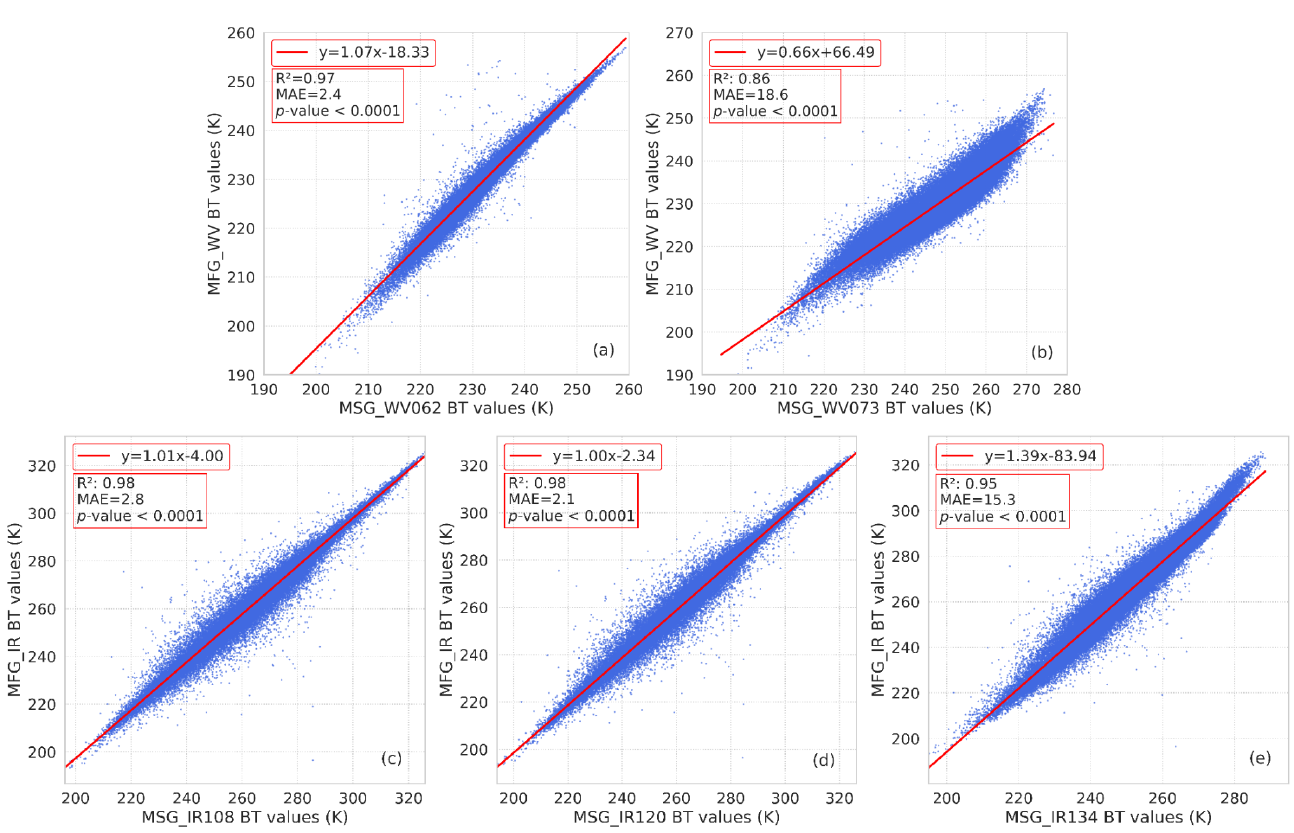
Figure 7. Scatter plots of MFG-MSG channels BT values (K). ( a ) MSG WV062 vs. MFG WV, ( b ) MSG WV073 vs. MFG WV, ( c ) MSG IR108 vs. MFG IR, ( d ) MSG IR120 vs. MFG IR, and ( e ) MSG IR134 vs. MFG IR. The red line in each scatter plot represents the best-fit regression line. These scatter plots were generated based on randomly selecting 100,000 MFG/MSG pixels from the overlap period